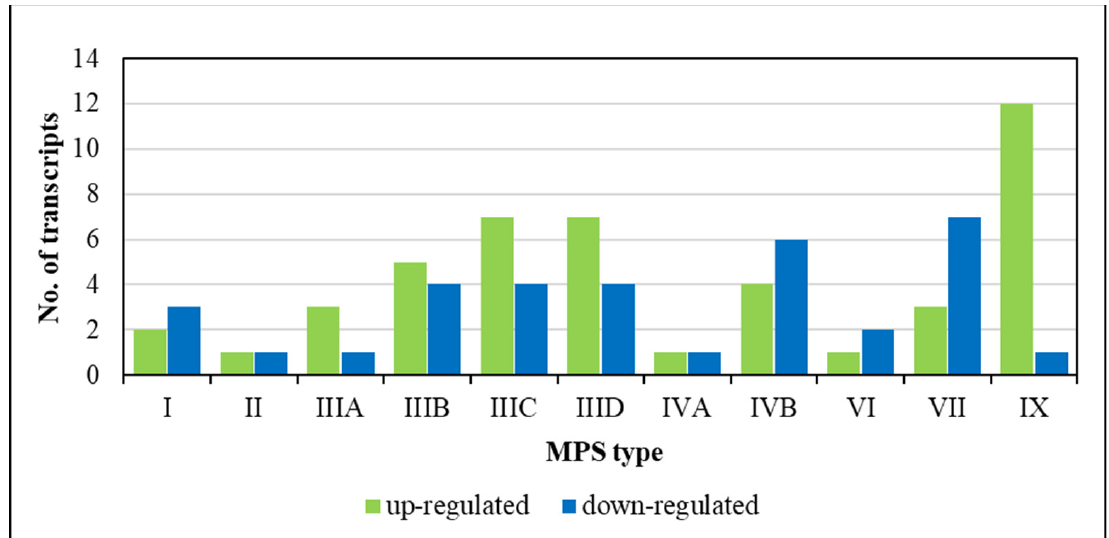
Figure 1. Number of up- and down-regulated transcripts of genes coding for lncRNAs (Gene Ontology term GO:0140742 (lncRNA transcription) in the QuickGO database (https://www.ebi.ac.uk/QuickGO/, last accessed on 5 December 2022)) in different types of MPS relative to control cells (HDFa). Table 2. Genes encoding lncRNAs whose expression is significantly changed in at least four MPS types relative to the control cells. Changes in expression (transcripts’ levels) of particular genes in MPS types are depicted, indicating log 2 fold change (FC) relative to control cells; up-regulation is marked in green while down-regulation in marked in blue; non-statistically significant differences are not